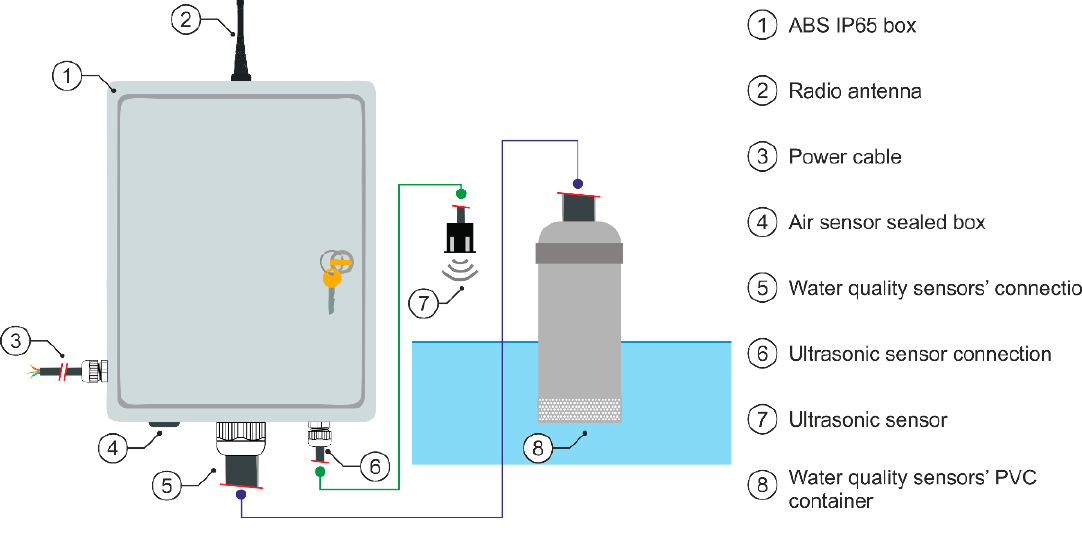
Figure 2. Initial sketch of the designed node.